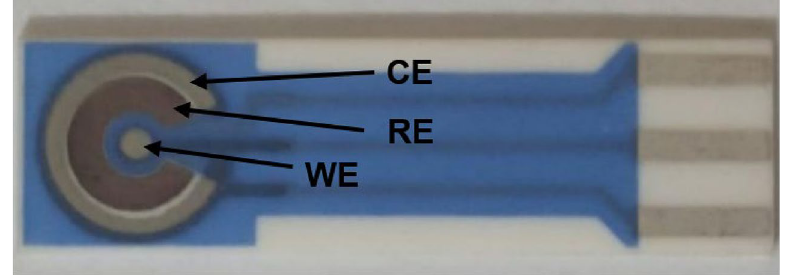
Figure 1. BVT screen printed